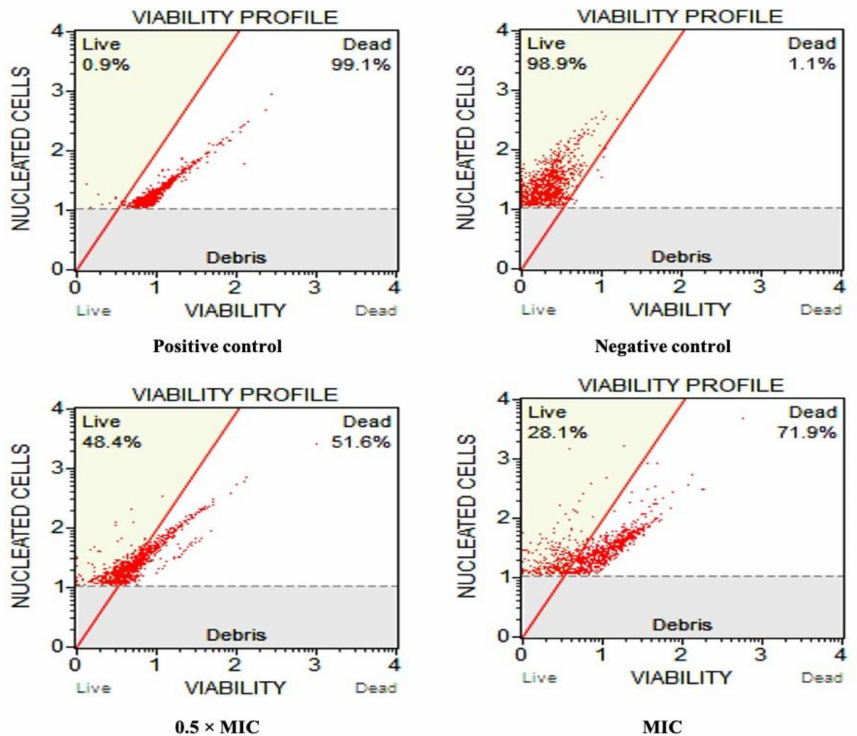
Figure 4. Viability profile of Candida albicans 5112 untreated cells (negative control), heat killed cells (positive control) and cells treated with 0.78 µ g/mL (0.5 × MIC) and 1.56 µ g/mL (MIC) of the bimetallic Ag-Ni